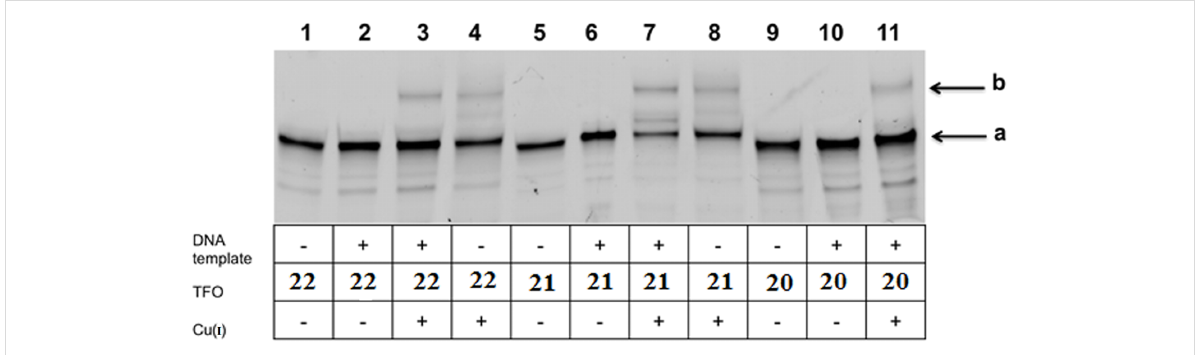
Figure 15: Electrophoretic analysis of reaction mixtures in standard 20% denaturing PAGE after DNA-templated synthesis. All reaction mixtures in the 0.1 M TEA-acetate buffer, pH 7.0 contained 10 µM polyamide 14 and components, indicated in the table. The concentrations of the DNA template (target duplex shown in Figure 3) and TINA-TFOs (shown in Figure 10) were 10 µM. Cu(I) was added as a mixture of components up to the final con- centrations of CuSO 4 and THPTA 5 mM and sodium ascorbate 10 mM.